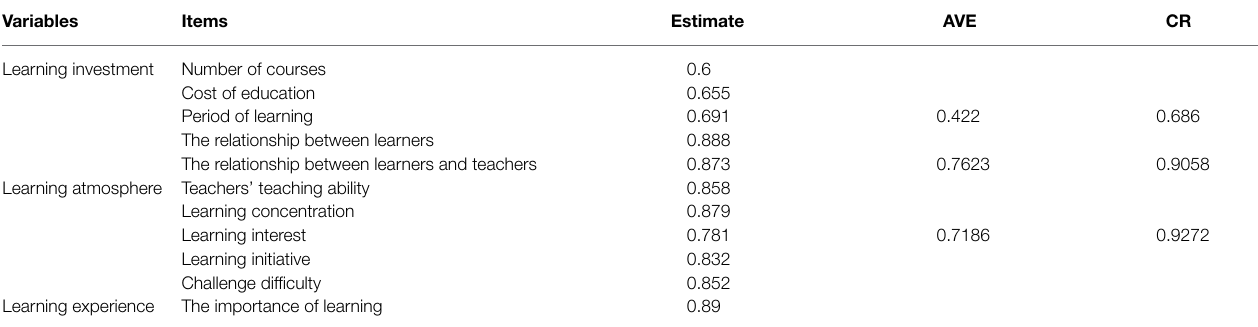
TABLE 2 | Results of confirmatory factor analysis (CFA) for older adult learning. Variables Items